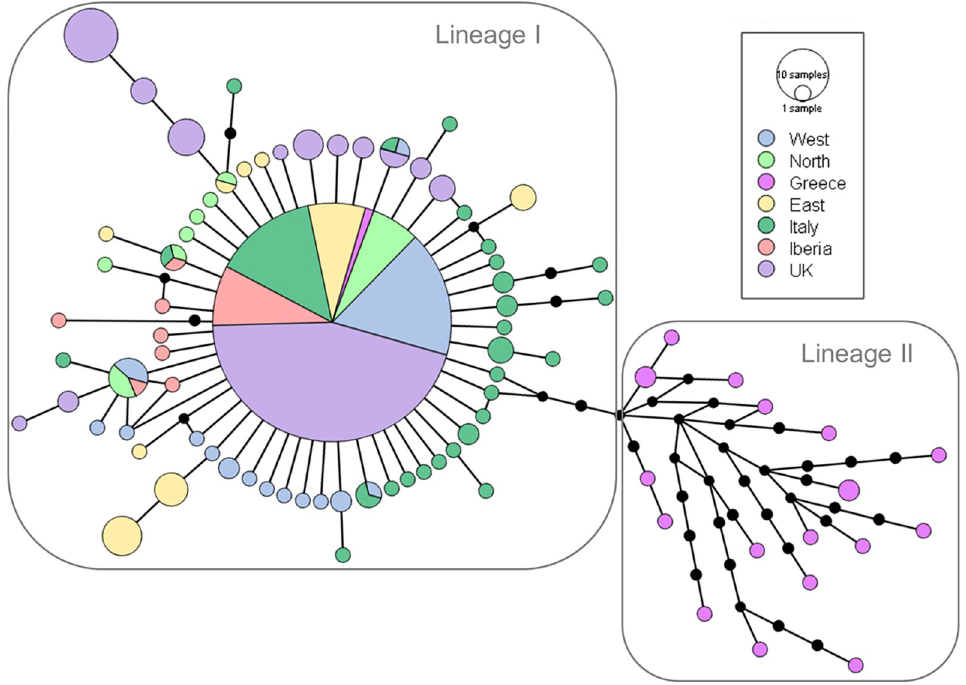
Fig 2. Median joining haplotype network of mitochondrial cytochrome oxidase subunit I ( COI ) haplotypes of Lucanus cervus in Europe. Partitions inside the circles represent the proportion of each region as given in Fig 1 within each haplotype. Circle size is proportionate with sample size. Haplotypes connected by a line differ in sequence by one mutational step and black dots represent unsampled or extinct